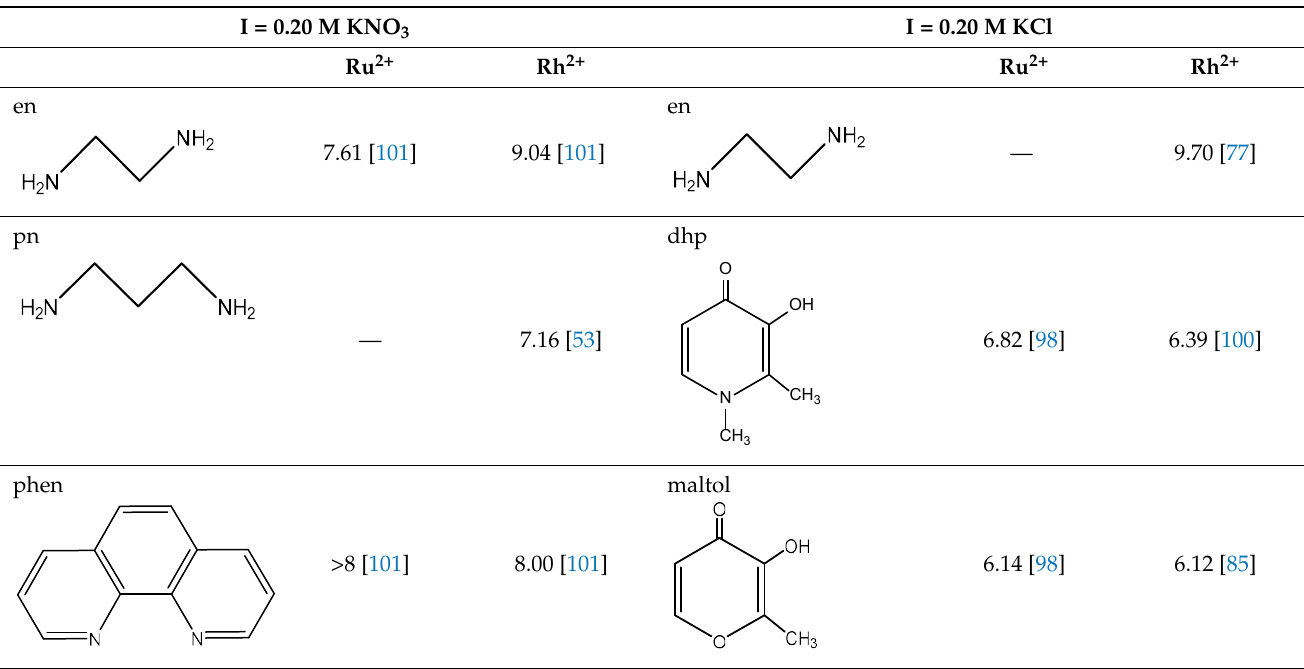
Table 4. pM’ 1:1 values (c M = c L = 1·10 −6 M, pH = 7.4) calculated for the solutions containing [(η 6 - p -